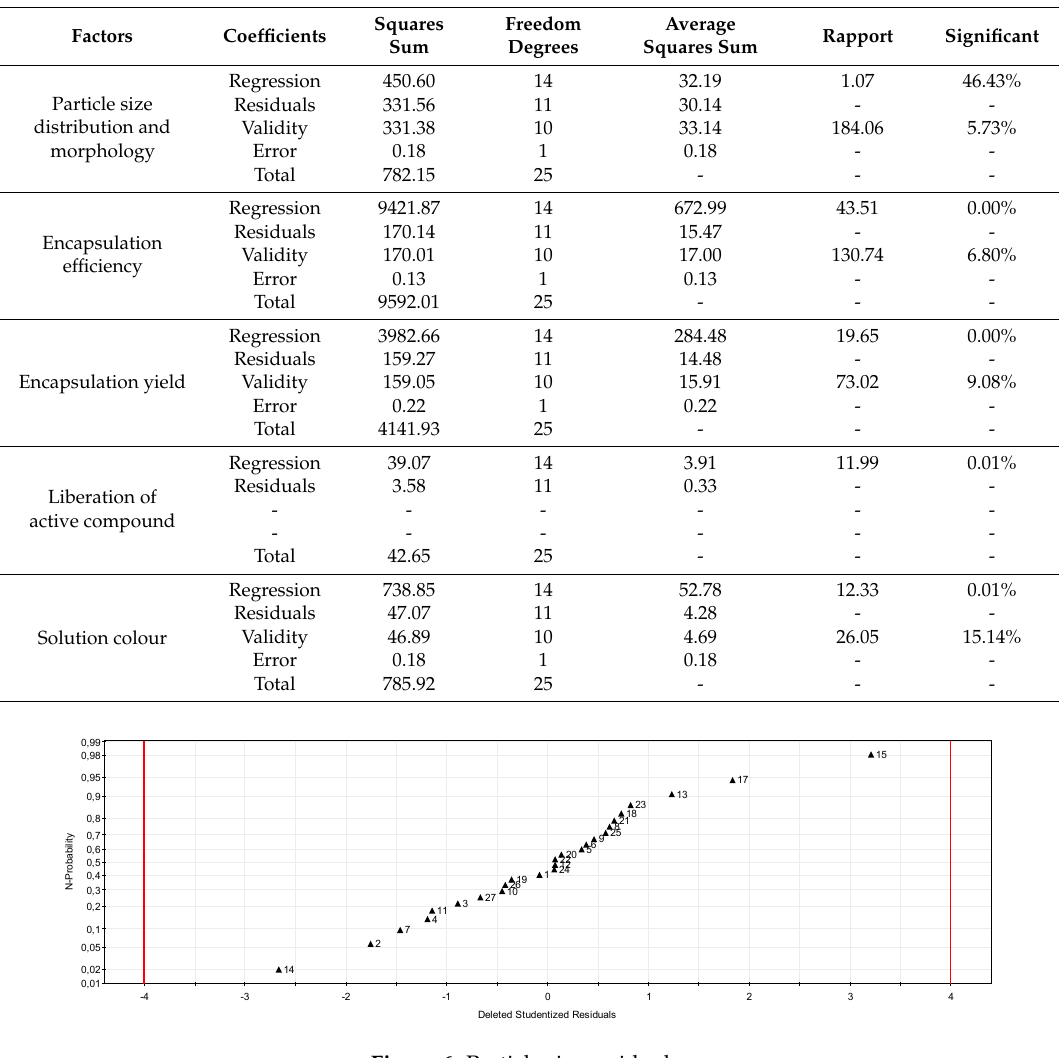
Figure 6. Particle size residuals.